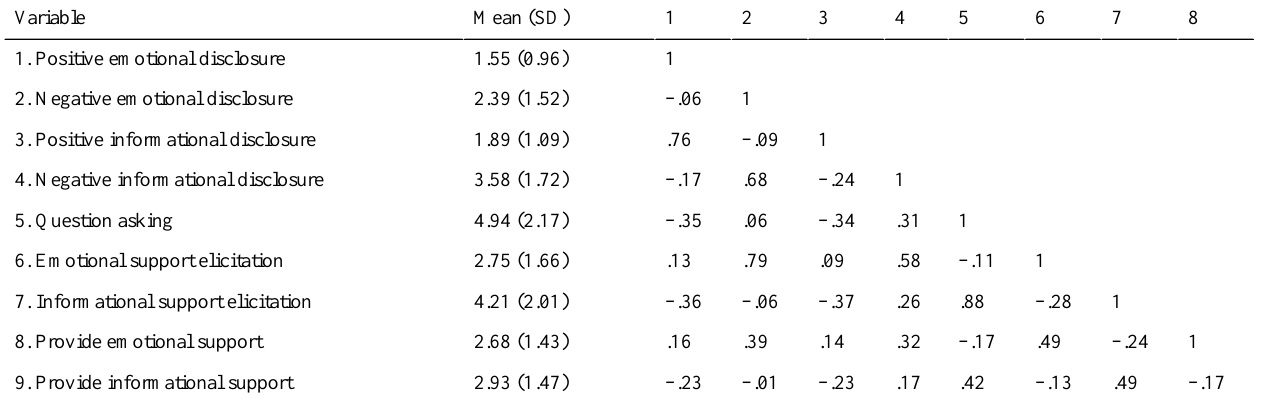
Table 2. Descriptive statistics and correlations among constructs coded by Turkers.